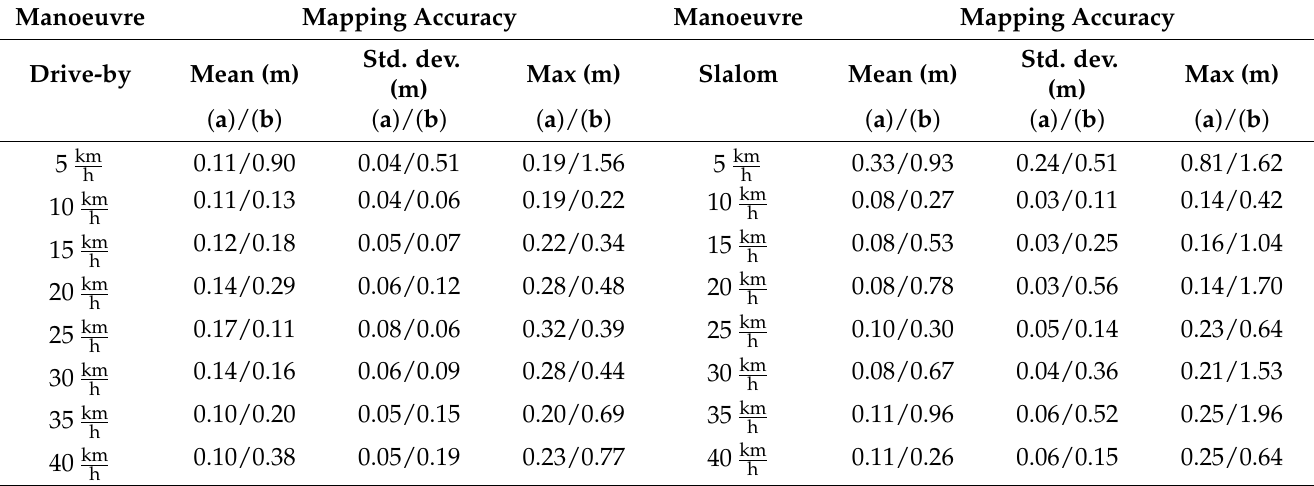
Table 3. Results of the mapping accuracy. Shown are the maneuvers, driving velocity, mean deviation from the observed to the true marker location, std. dev. of the errors and the maximum deviation. The columns ( a ) show the results when using position, velocity and orientation correction data. The columns ( b ) show the results when using only velocity correction data. Manoeuvre Mapping Accuracy